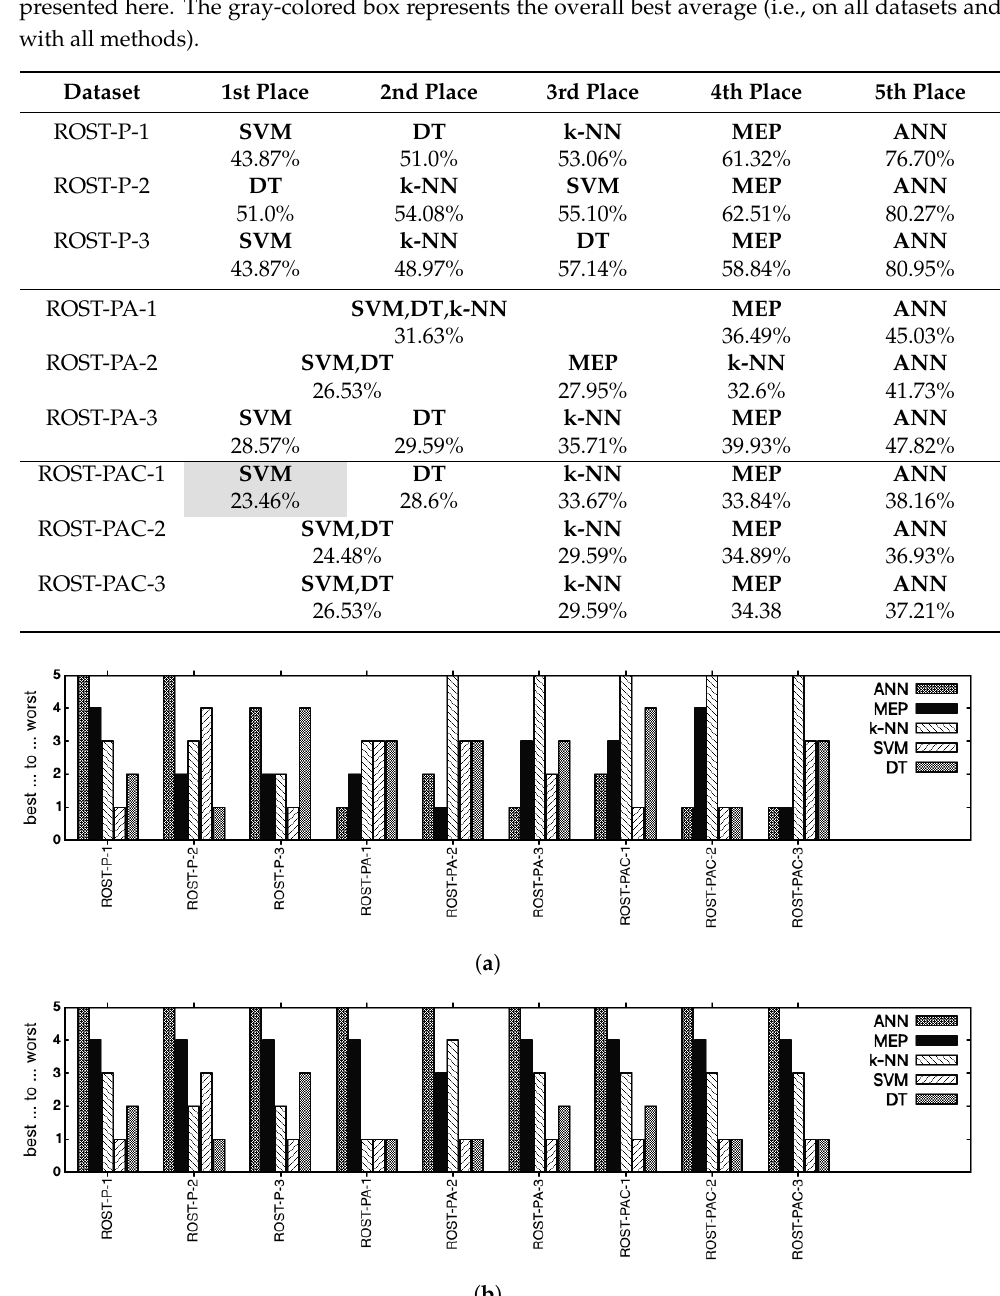
Figure 1. Top of methods on each shuffle of each dataset. Lower values are better. ( a ) Top of best results obtained by all methods ( b ) Top of average results, when applicable (i.e., over 30 runs for ANN and